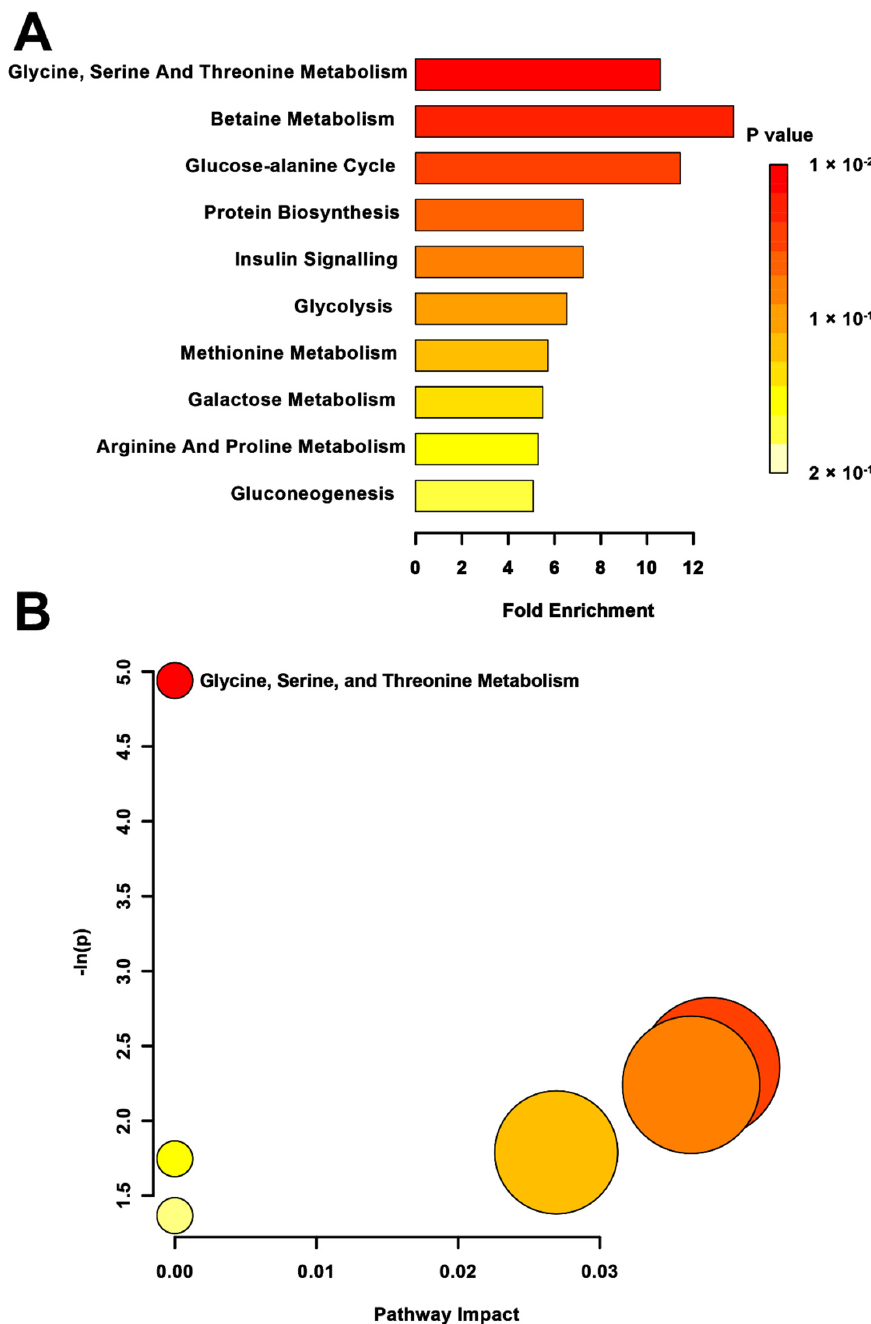
Figure 3. Pathway-associated metabolite set enrichment analysis (MSEA) for MPS vs. CONT. ( A ) Plot displaying affected biological processes in multigenerationally stressed (MPS) compared to non-stressed control (CONT) rats based on metabolites identified as significantly different between these groups. The p -value for each pathway is indicated in the gradient on the right side. The fold enrichment shows how many times greater than chance the pathway is involved. ( B ) Metabolomic pathway analysis showing all matched pathways according to p -values from pathway enrichment analysis and pathway impact values from pathway topology analysis in MPS and non-stressed CONT rats. The y-axis shows the negative natural log of p , such that a higher value on the y-axis gives a lower p -value. The x-axis indicates the pathway impact, which correlates to the number of metabolite hits in a particular pathway. Only metabolic pathways with p < 0.05 are labeled. MPS had the highest impact on the glycine, serine, and threonine metabolism.